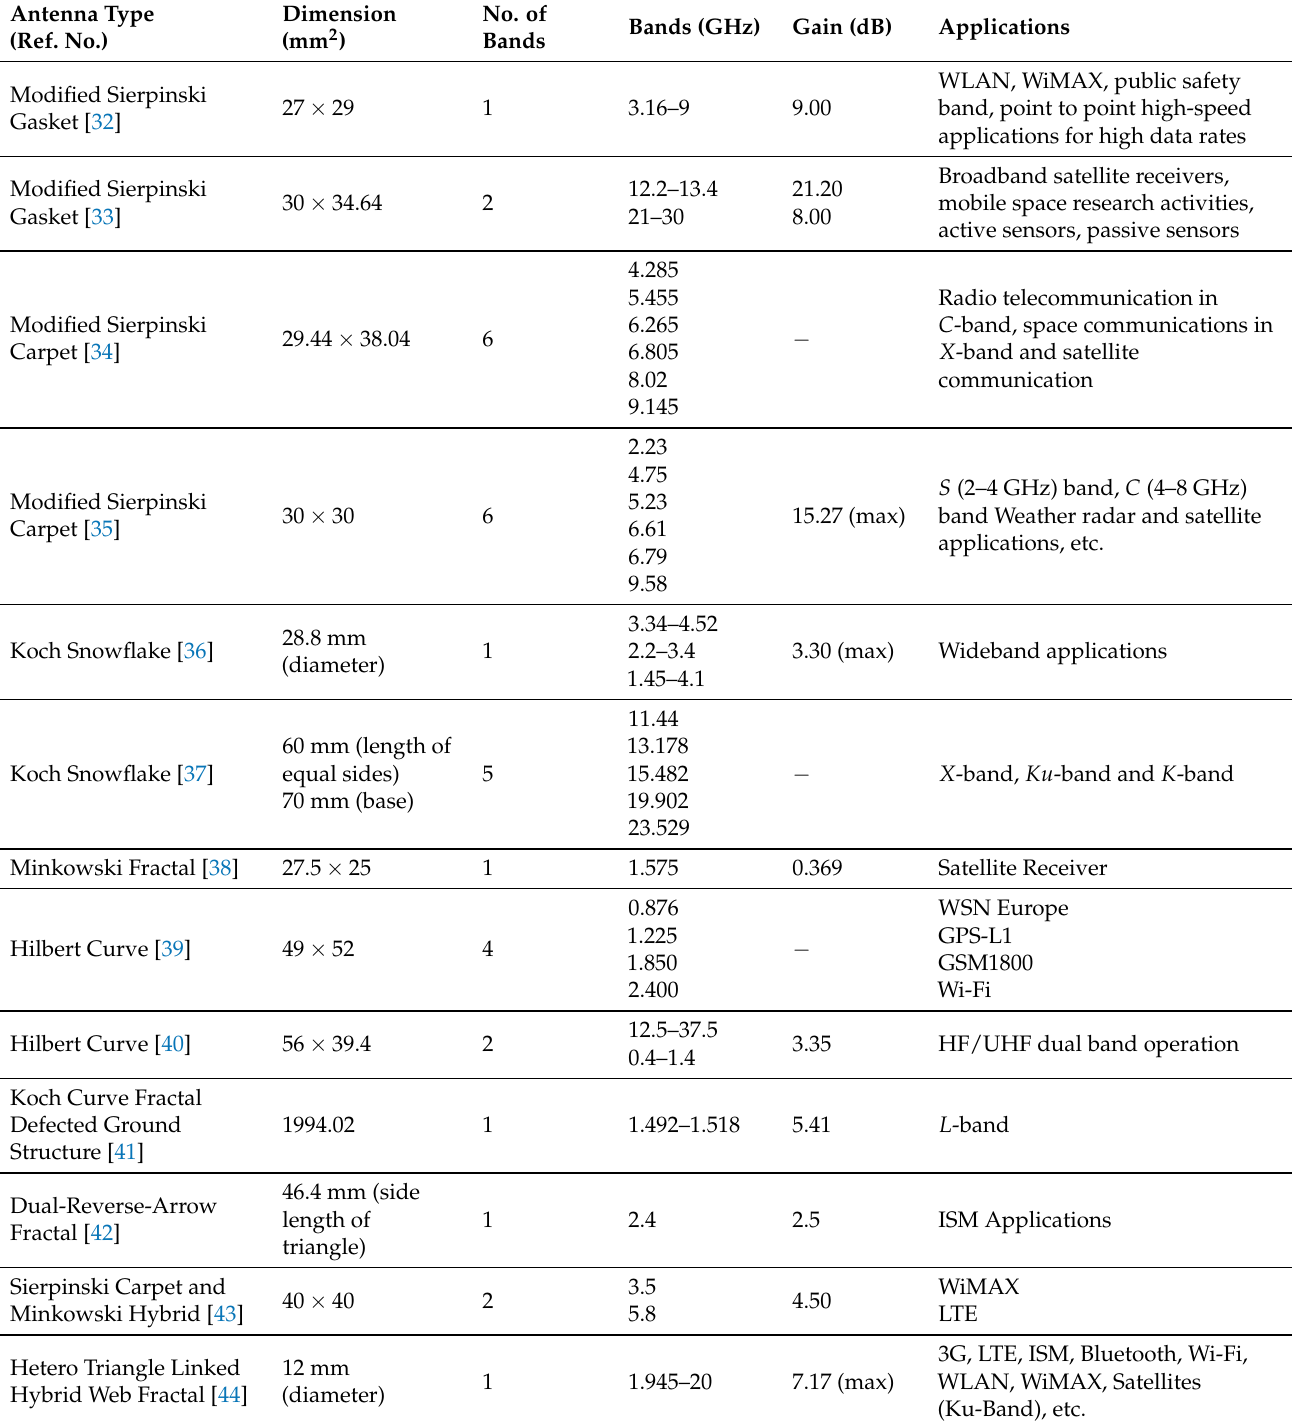
Table 2. Summary of the performance of some fractal